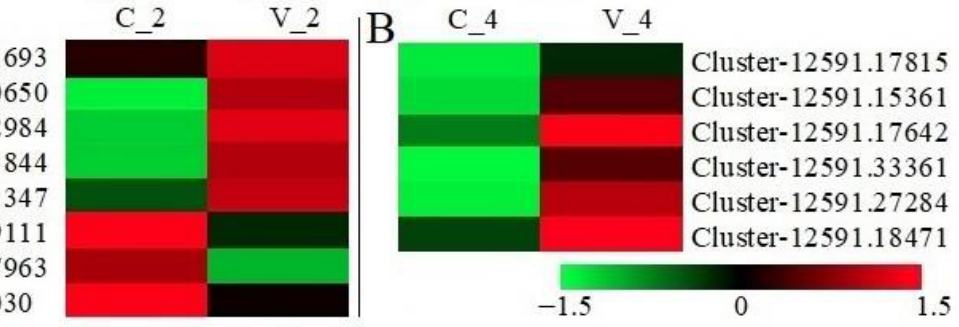
Figure 4. Heatmaps of 8 significantly expressed genes at 2 dpi ( A ) and 6 significantly expressed genes at 4 dpi ( B ). C_2 and C_4—the average of three biological replicates of mock-inoculated plants at 2 and 4 dpi, respectively. V_2 and V_4—the average of three biological replicates of BRV-inoculated plants at 2 and 4 dpi, respectively. In the scale bar, green color indicates low ( − 1.5) gene expression values, and red color indicates high expression (1.5).